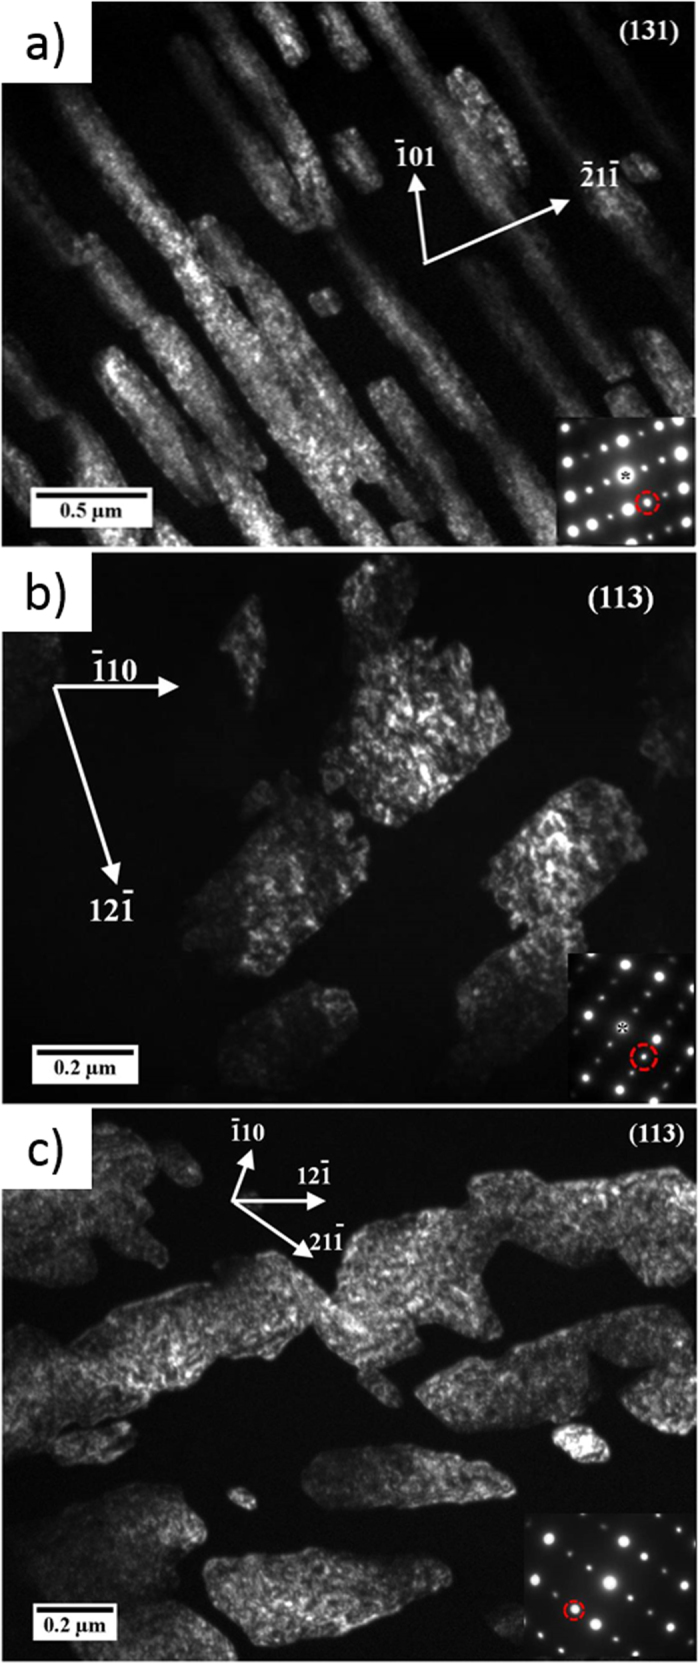
Dark-field TEM images showing ω phase (bright areas) in (a) [110] monocrystalline Ta driven energy of 625 J (foil at 200 μm below the crater, corresponding to pressure of ~71 GPa); (b) [111] monocrystalline Ta driven energy of 661 J (foil at 245 μm below the crater, corresponding to pressure of ~71 GPa); (c) [123] monocrystalline Ta driven energy of 633 J.For a nominal 650 J shot at 200 μm below the crater the corresponding pressure is ~71 GPa.